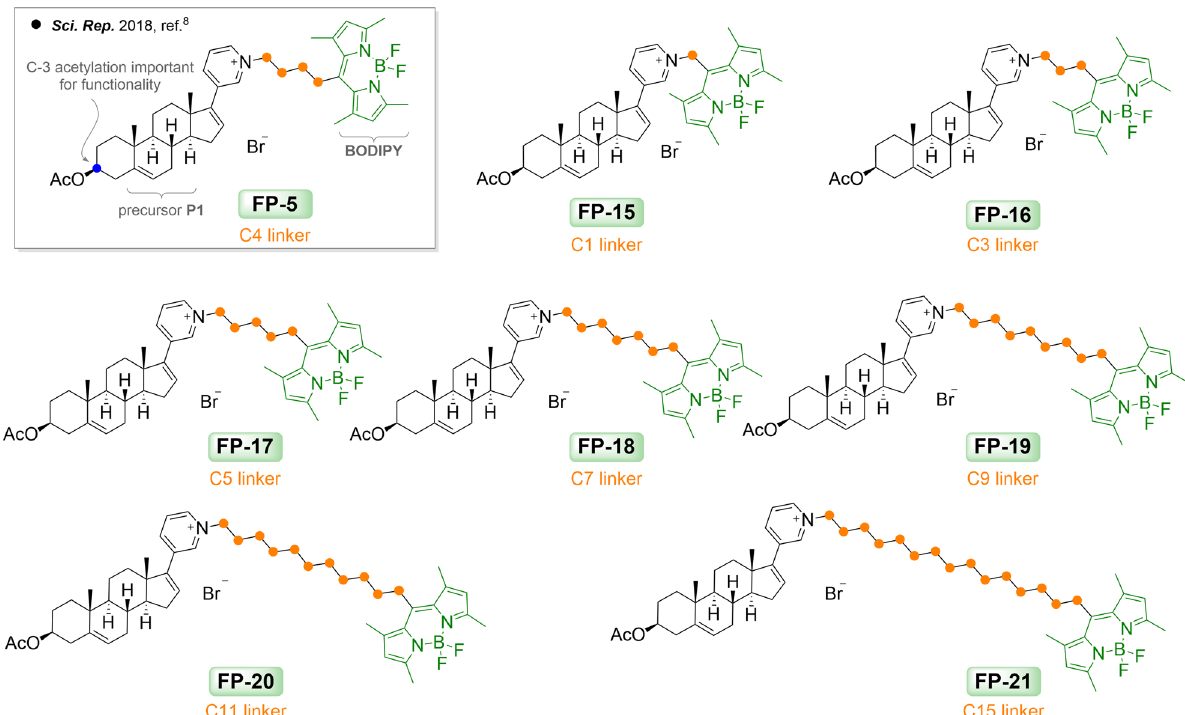
Figure 2. Probes FP-5 and FP-15–FP-21 with shortened and extended length of side